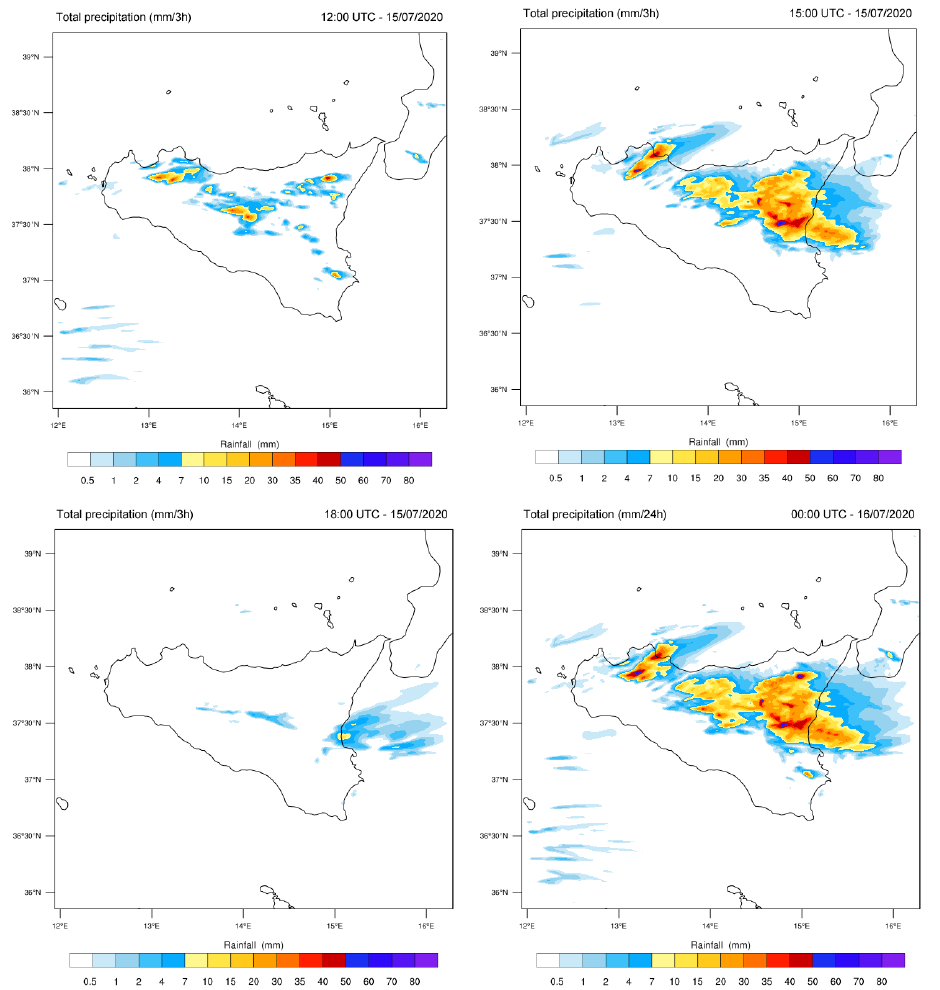
Figure 25. Cumulative rainfall every three hours predicted by the WRF model with a domain of 1 km and calculated at 12:00 UTC ( top left ), 15:00 UTC ( top right ), and 18:00 UTC ( bottom left ) of 15 July 2020. The cumulative rainfall calculated along the whole day are reported in the bottom right